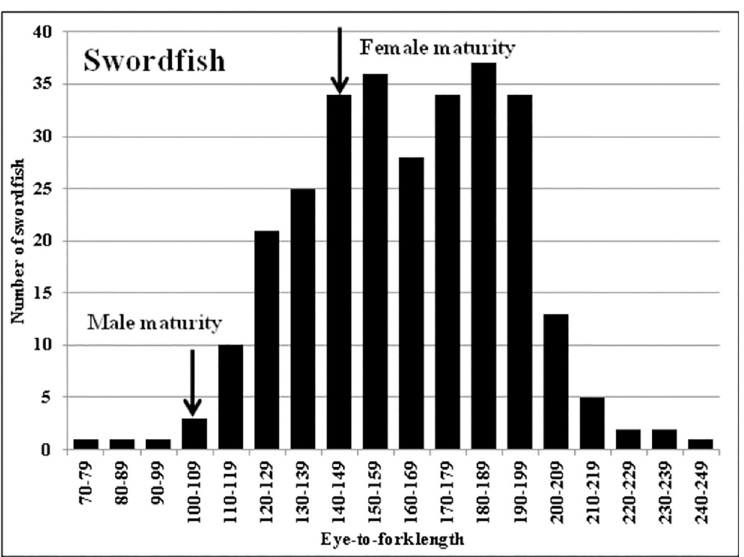
Fig 2. Length-frequency distribution of swordfish sampled in the diet study. N = 293. Arrows indicate typical sizes at maturity for males and females [76]. Eye-to-fork length is measured in cm. (Size was not determined for 6 individuals of the 299 sampled).